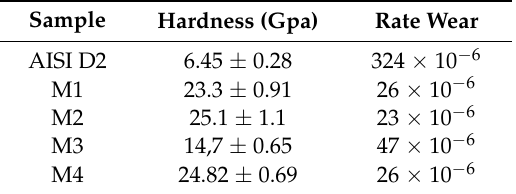
Figure 6. XPS spectra of the coatings deposited on the M2 sample. ( a ) survey spectra; ( b ) high resolution of C 1 s ; ( c ) high resolution of Cr 2 p ; ( d ) high resolution of O 1 s . Table 3. Hardness of the coatings deposited on AISI D2.